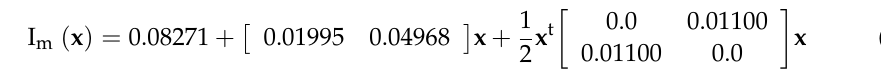
Table 4. Optimal configurations considering different limits for electric current density.